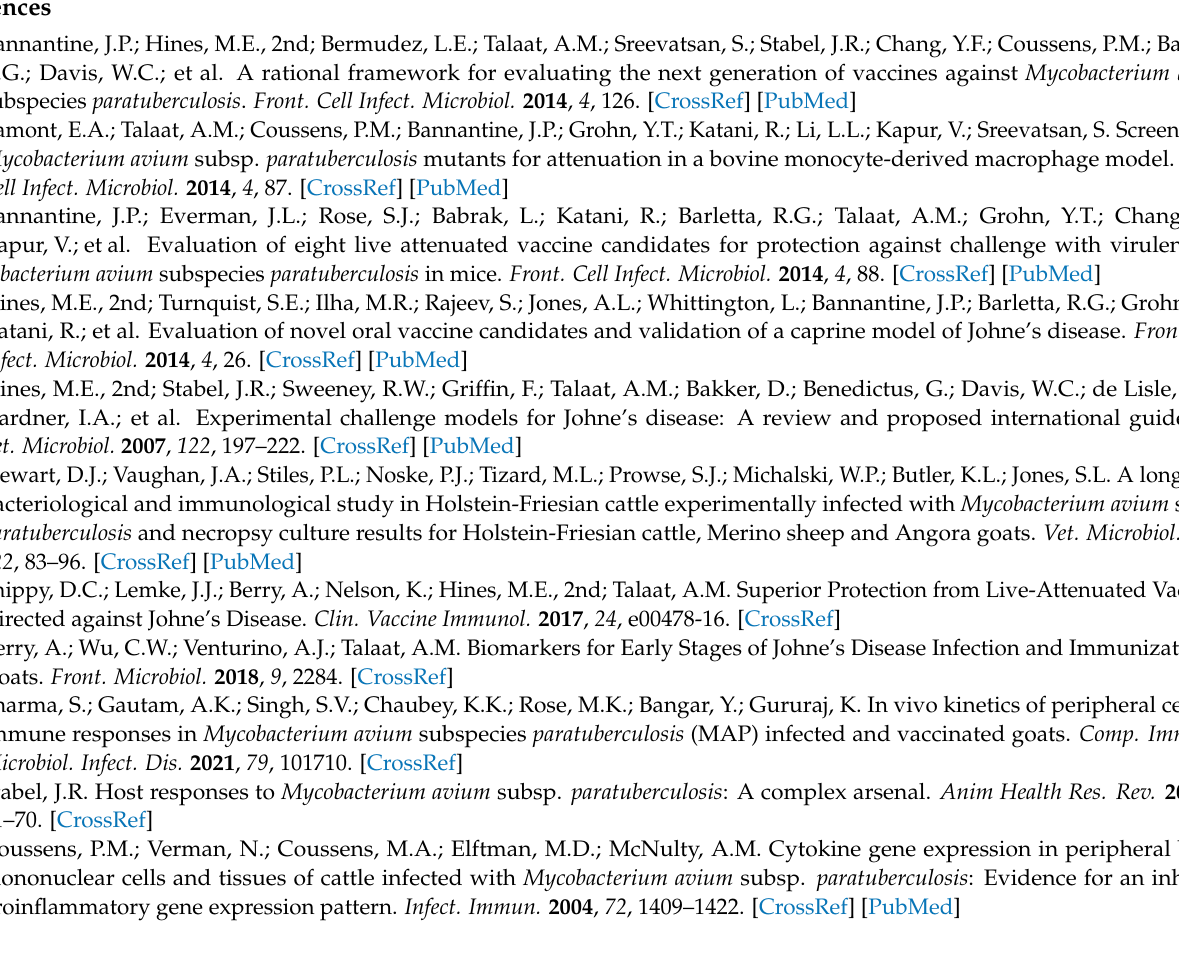
Table S1: Sequence data of subcloned inserts obtained from the Map -lambda phage expression li- brary, Table S2: Relative antigenicity of recombinant proteins probed with two infected goats and two vaccinated